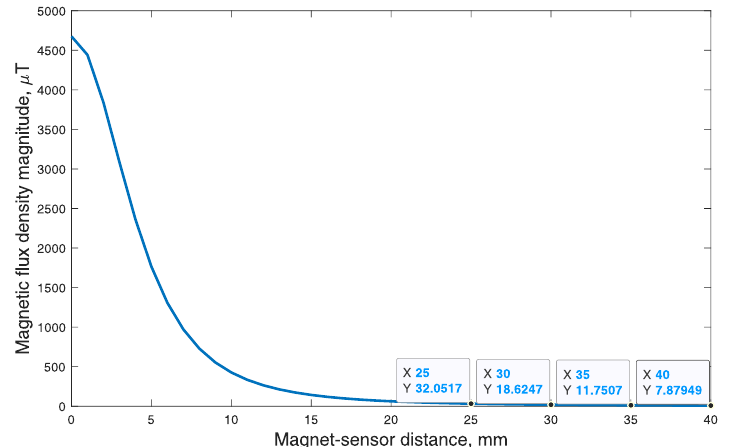
Figure 8. Magnetic flux density magnitude dependency from lateral (z) magnet-sensor distance. Note that vertical distance (y) was constant at 6 mm, which is the zero-point of working range.